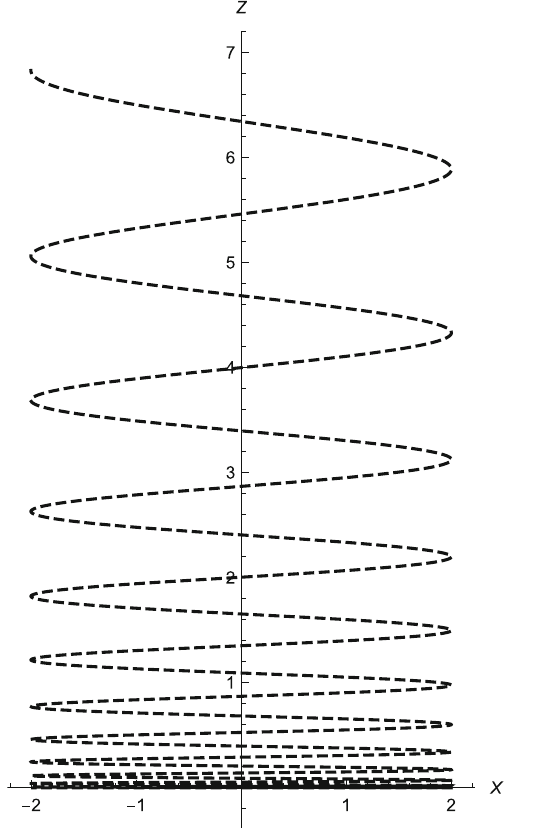
Fig. 4 Trajectory in the XZ plane for β = 1 / 100, b 0 = 1 and n (cid:6) = 1